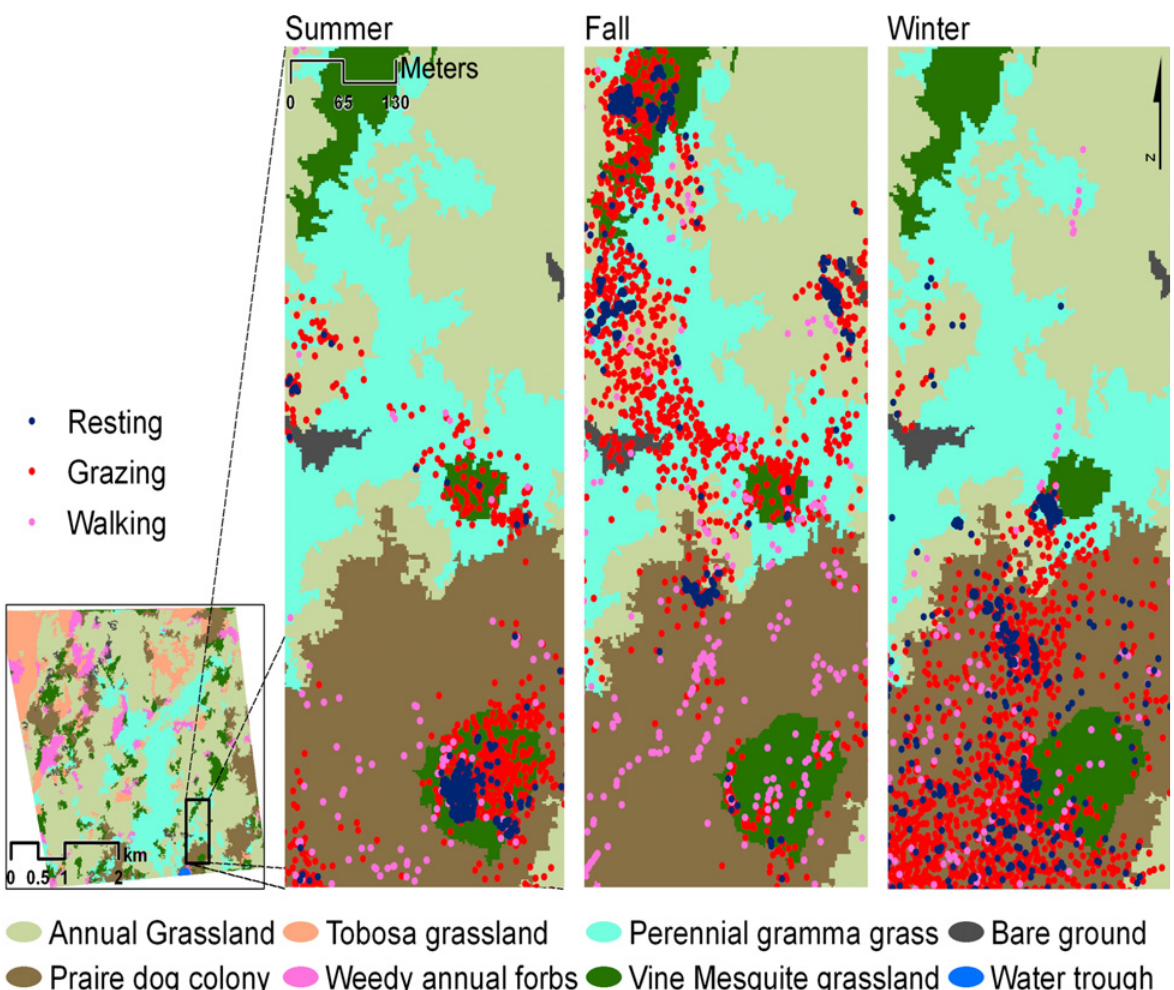
Fig 1. Spatial pattern of the three classes of cattle activity relative to the vegetation/ground cover types through seasons. Colored dots indicate cattle locations by activity across all weeks during each sample